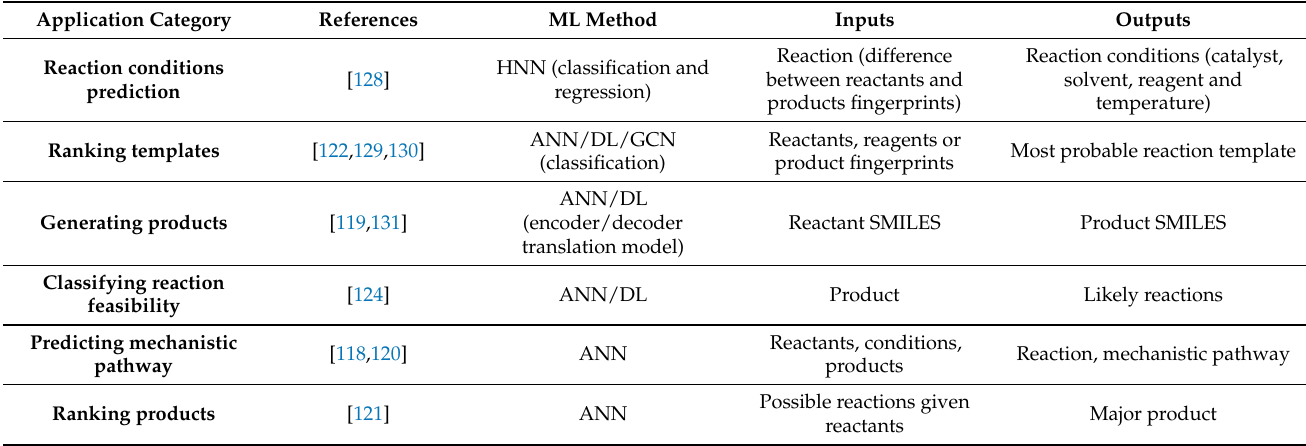
Table 6. Applications of ML in reaction prediction and retrosynthesis. Acronyms: ANN: artificial neural network, DL: deep learning, GCN: graph convolutional network, HNN: hierarchical neural network, and SMILES: simplified molecular input line entry